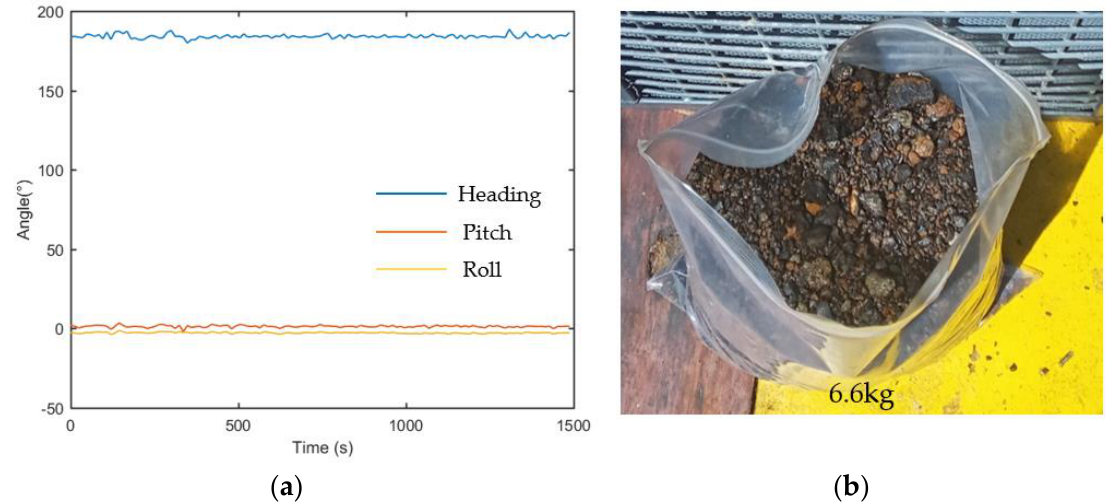
Figure 18. The attitude and heading angle of vehicle ( a ), particles collected by this cutting test ( b ).